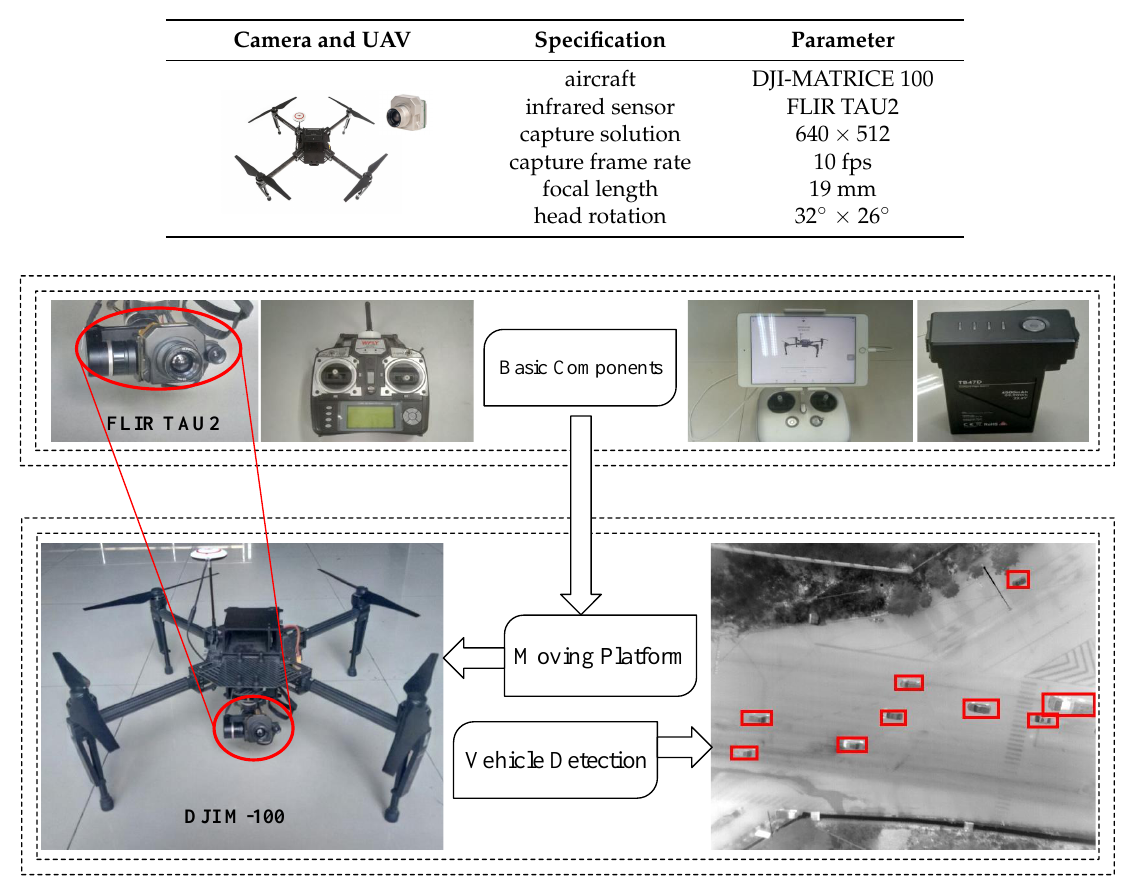
Table 2. The equipment and parameters.